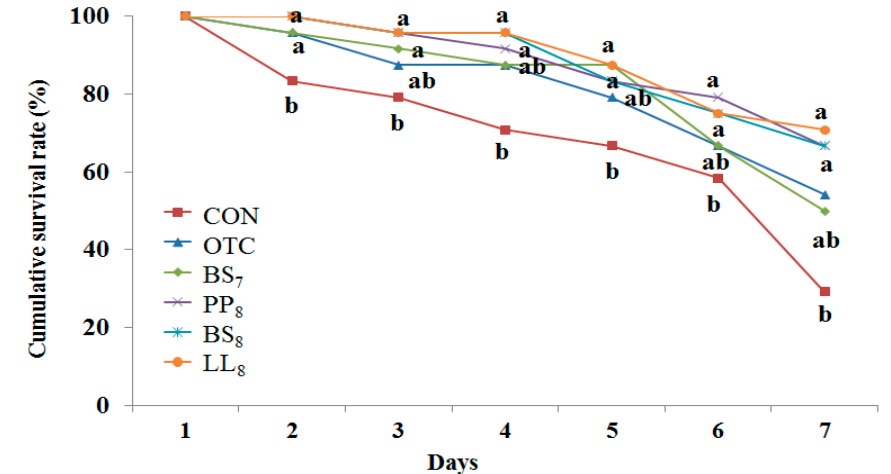
Figure 3. Cumulative survival rate of juvenile whiteleg shrimp fed the experimental diets with different probiotics for 8 weeks and experimentally challenged with V. parahaemolyticus for 7 days. Each value represents mean of triplicate groups. Significant differences among means are indicated by different superscripts ( p < 0.05), and diets refer to Figure 1.